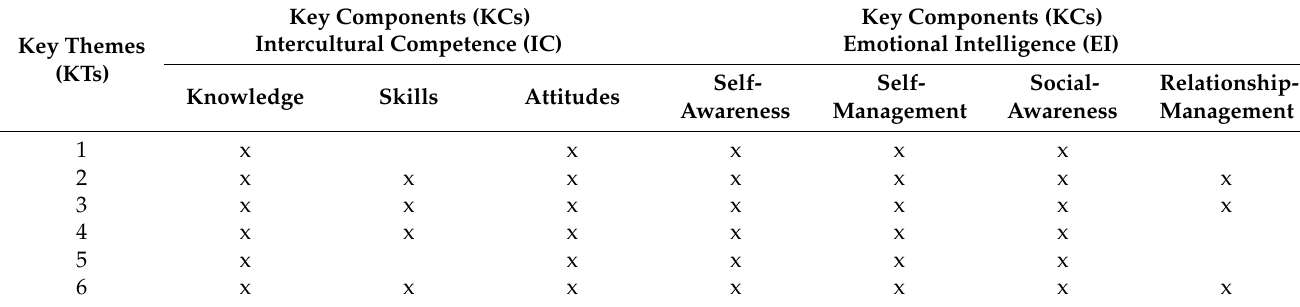
Table 4. Visual summary of convergence between key themes (KTs) and key components (KCs) of IC and EI. Key Components Key Themes (KTs)